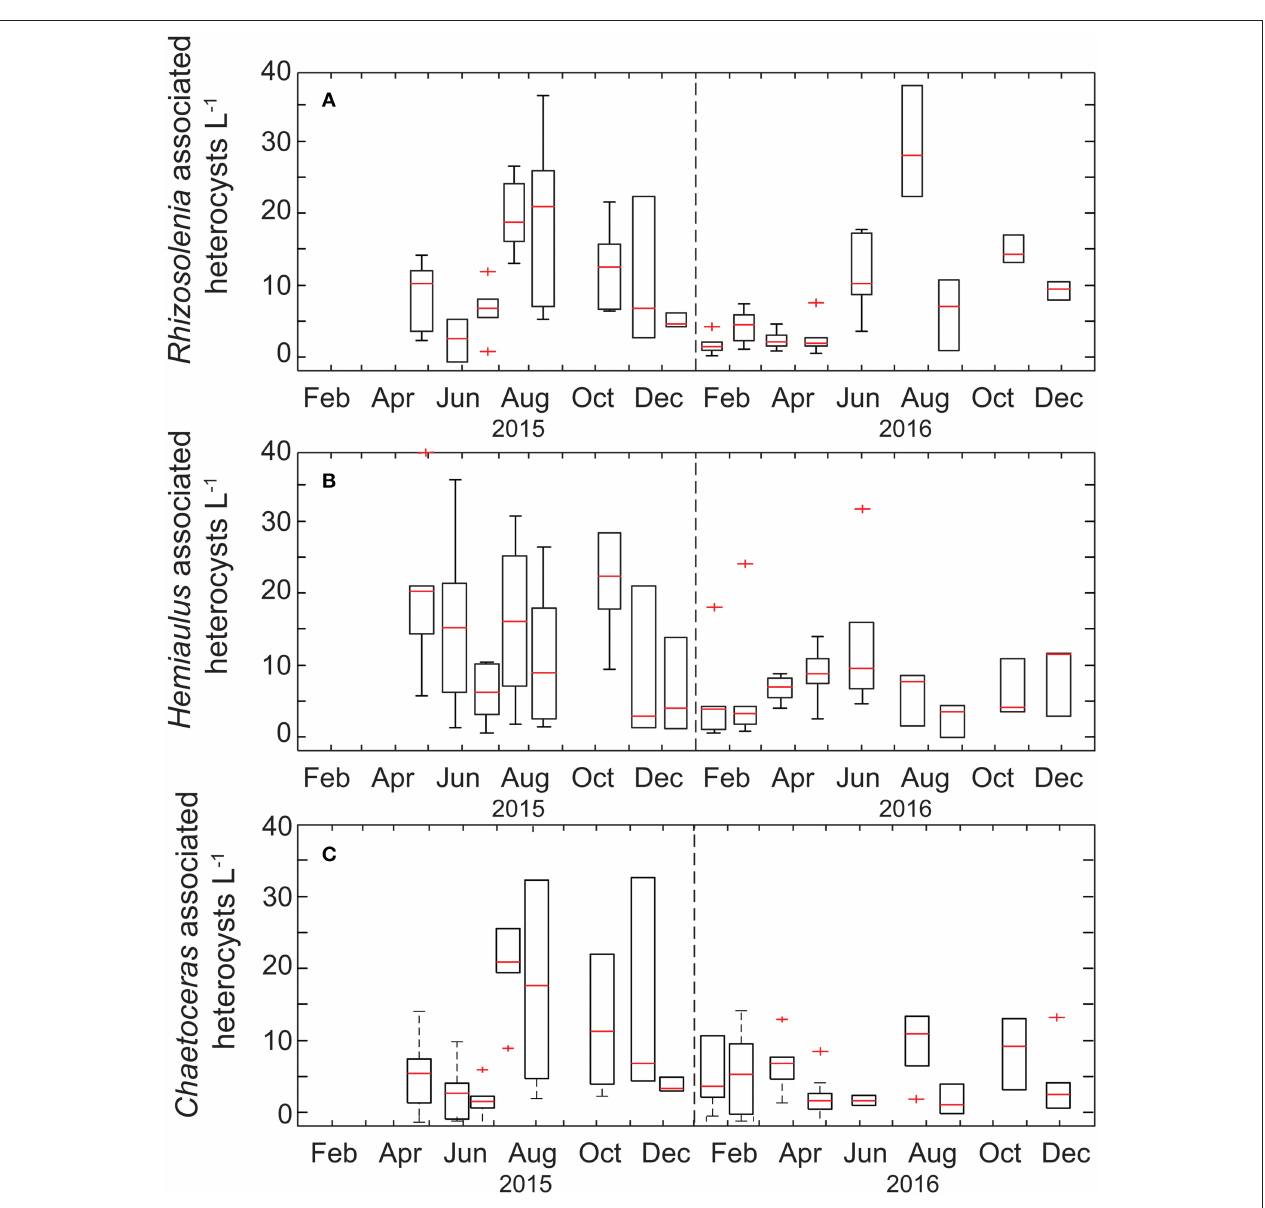
FIGURE 3 | Box-plots of the monthly time-series of heterocysts associated with diatom genera (A) Rhizosolenia , (B) Hemiaulus, and (C) Chaetoceros . The range of each box spans the 25th − 75th percentile of data for each month whereas whiskers are ± 2.7 standard deviations, the red line is the median, and plus symbols are